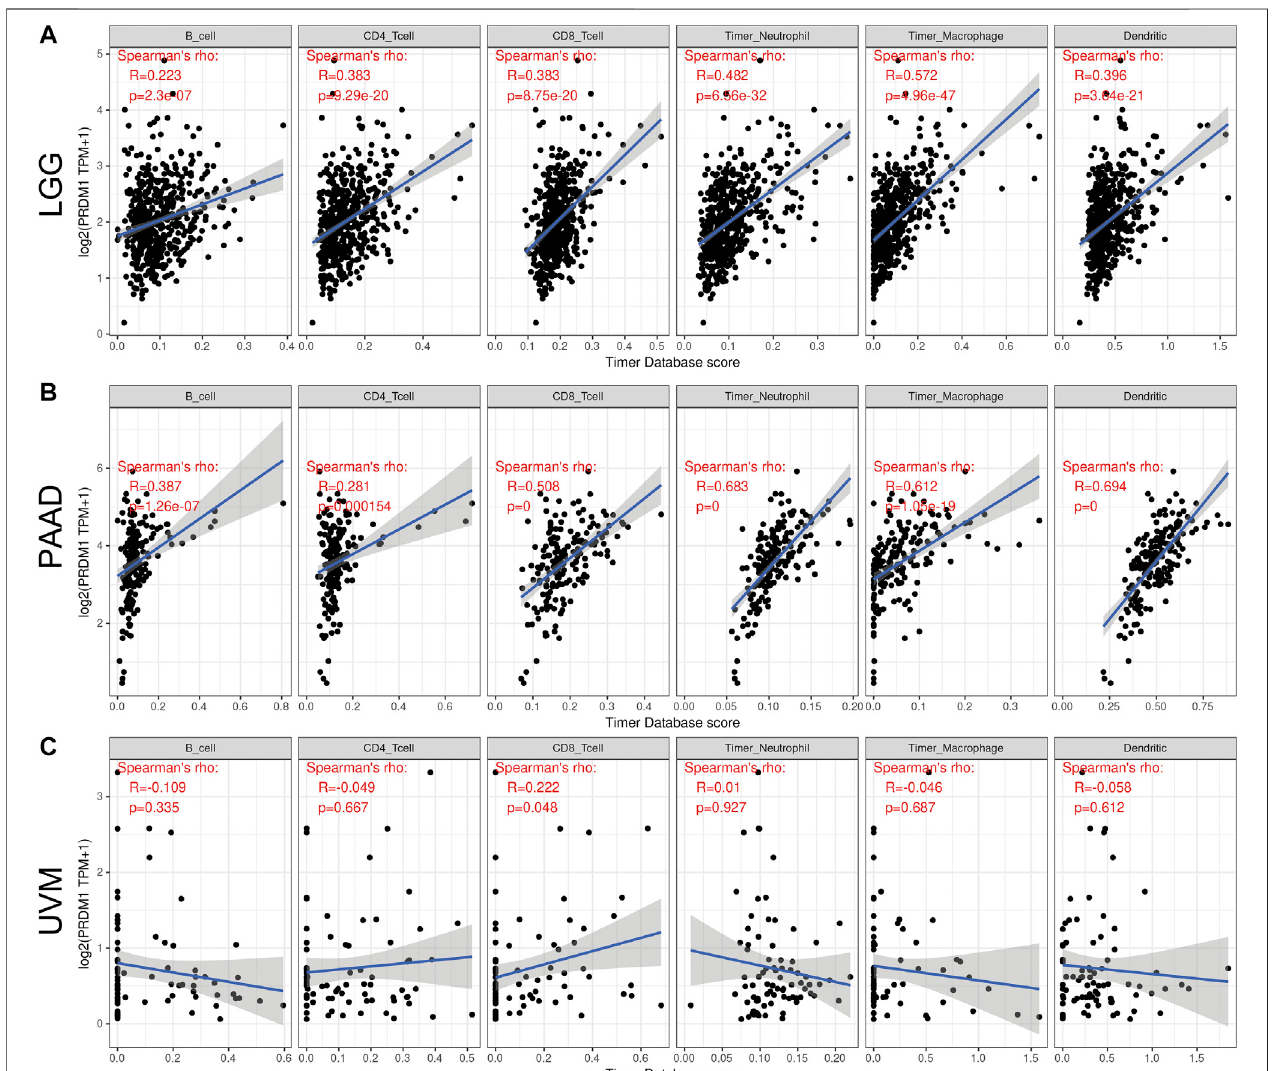
FIGURE 3 | Correlation of PRDM1 expression with immune in fi ltration level in low grade glioma (LGG), pancreatic adenocarcinoma (PAAD) and uveal melanoma (UVM) (A and B) PRDM1 expression is signi fi cantly positively correlated with B cell, CD4 T cell, CD8 T cell, Neutrophil, Macrophage and Dendritic Cell in fi ltration in LGG and PAAD (C) PRDM1 expression is signi fi cantly positively correlated with CD8 T cell in UVM.